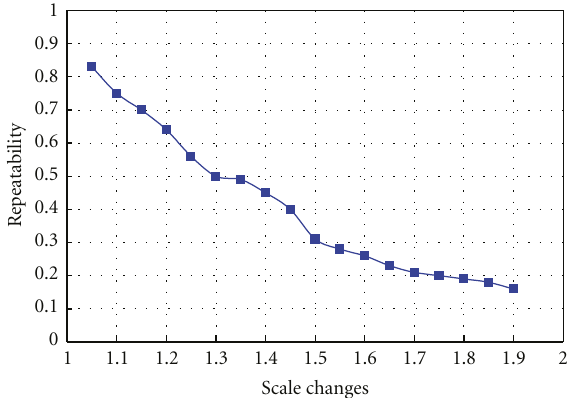
Figure 2: Repeatability of Harris points under di ff erent scale